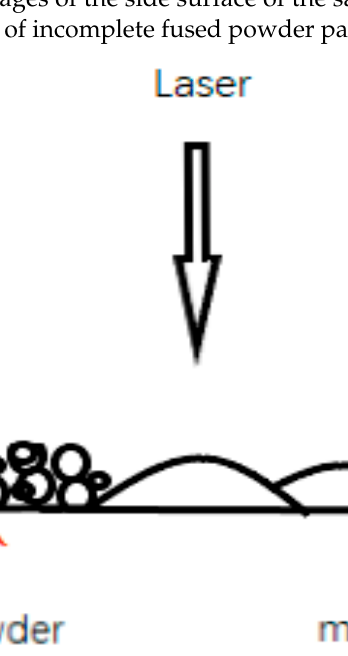
Figure 2. Diagram of molten channel.